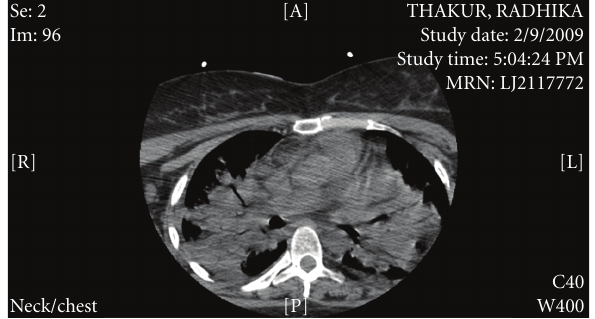
Figure 2: CT chest showing the di ff use bilateral pulmonary